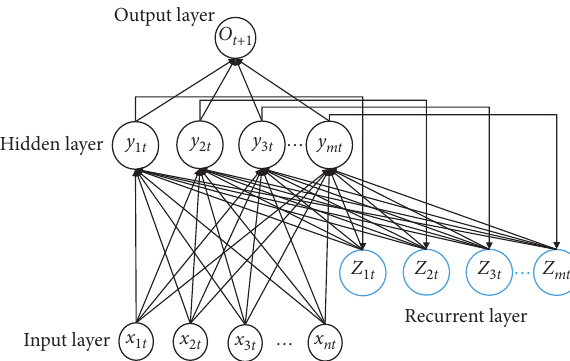
Figure 1: Topology of the Elman neural